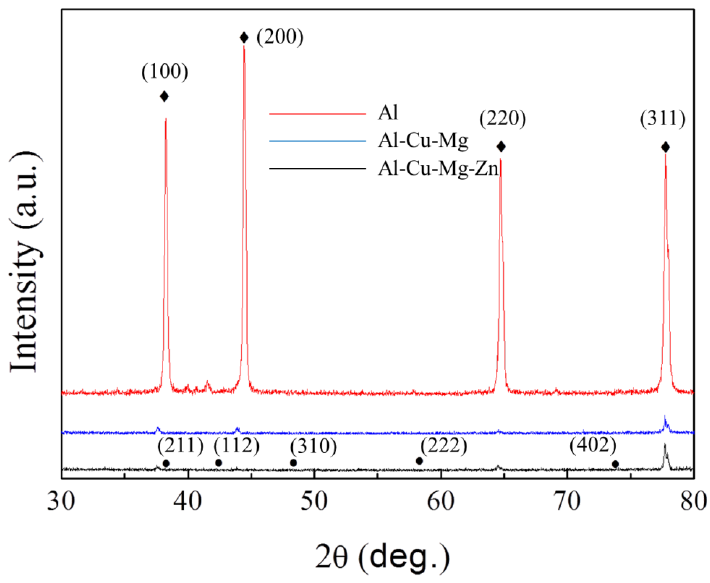
Figure 2. X-ray diffraction (XRD) patterns of the Al-Cu-Mg and Al-Cu-Mg-Zn alloys by pulsed electrical discharge (PED) treatment with pure Al as reference.